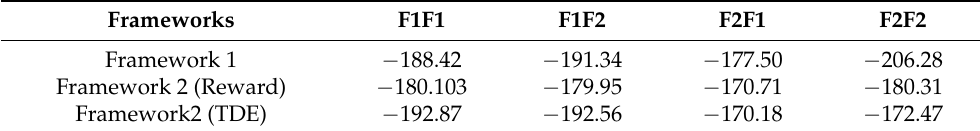
Table 5. The average performance of the frameworks across the buffer sizes with a sampling ratio of 9:1.